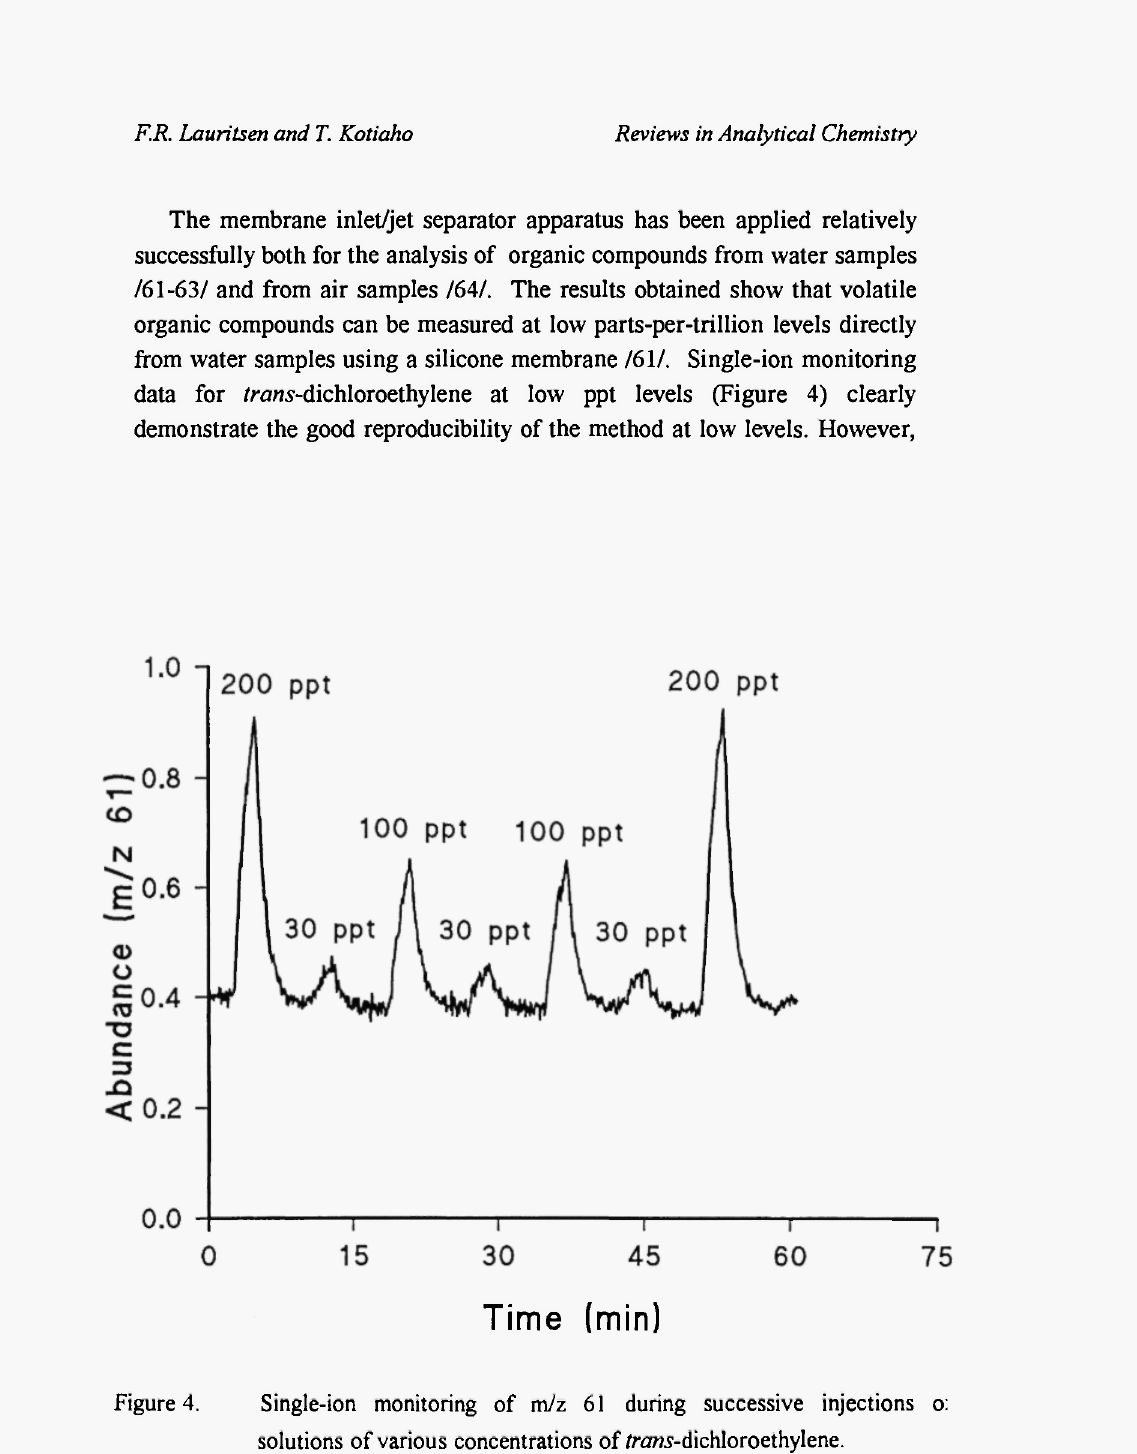
Figure 4. Single-ion monitoring of m/z 61 during successive injections o: solutions of various concentrations of /rans-dichloroethylene. Reprinted from reference [61] by permission of John Wiley & Sons, Ltc